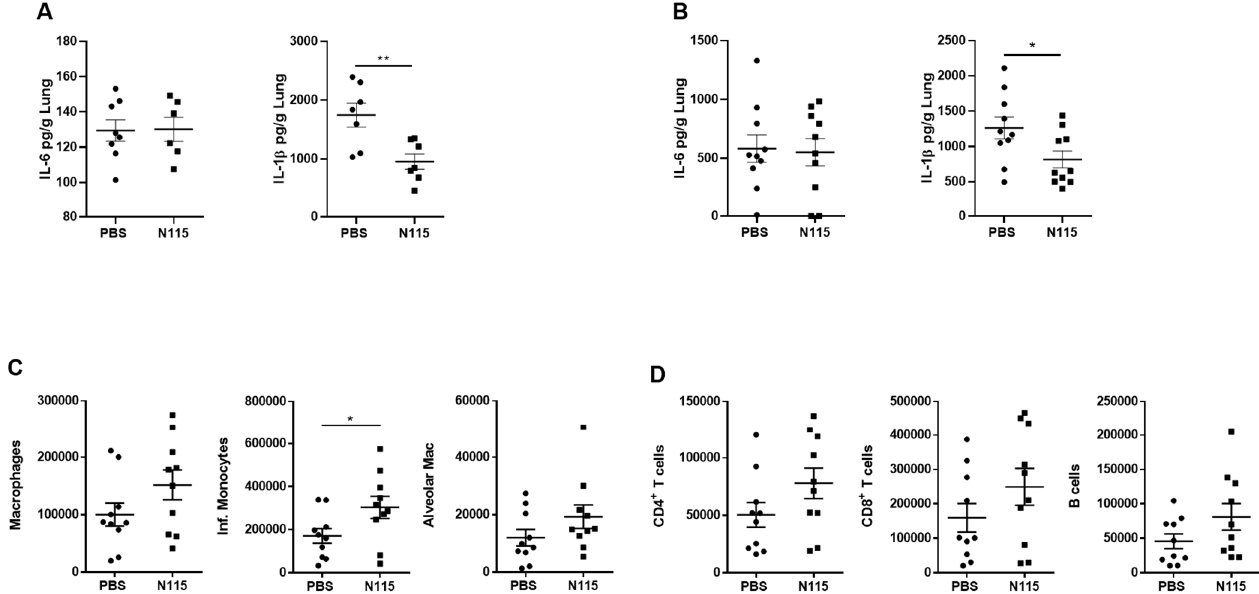
Figure 4. N115 treatment modulates inflammatory responses during IAV infection. WT C57BL/6J mice were anesthetized and infected with 250 PFU of influenza A/PR/8/34 H1N1. Mice were treated 3 times a daily for 20 min/treatment with either nebulized 20 mM NaPyr (N115) or nebulized PBS as control. Mice were euthanized on day 3 ( A ) or day 7 p.i. ( B – D ) for tissue collection. Lung samples were then homogenized and examined via ELISA for cytokine production ( A , B ) or cellular infiltration into the lungs by flow cytometry ( C , D ). Data are combined from 2 independent experiments with n = 3–5 mice per experiment. Statistical significance was determined using a Student’s t -test for single comparisons. * p < 0.05, ** p < 0.01.